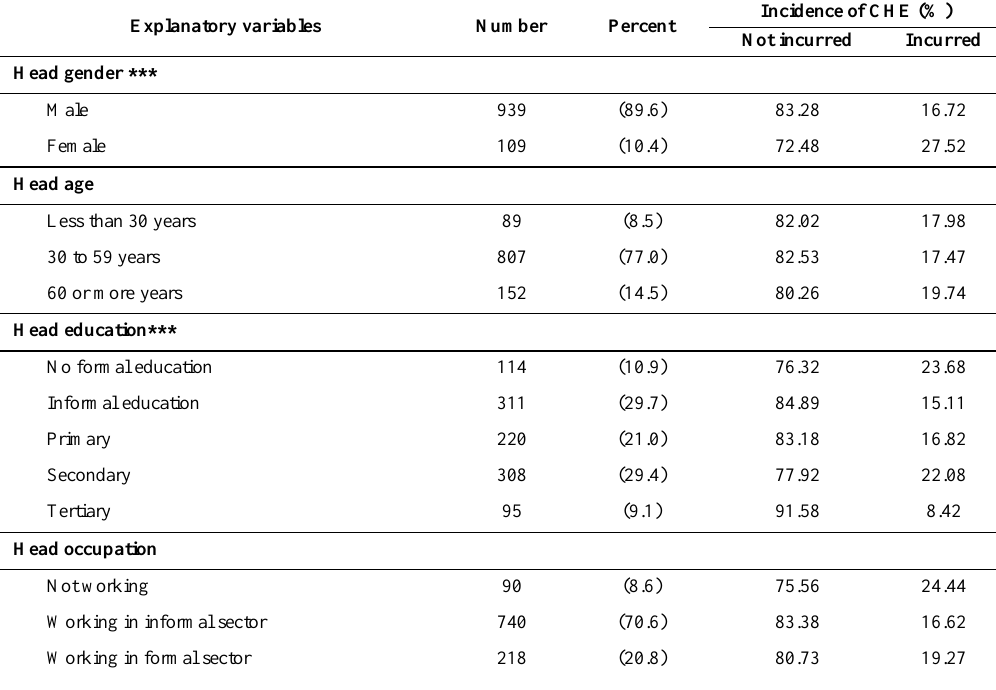
Table 2. Households experiencing CHE according to head and household